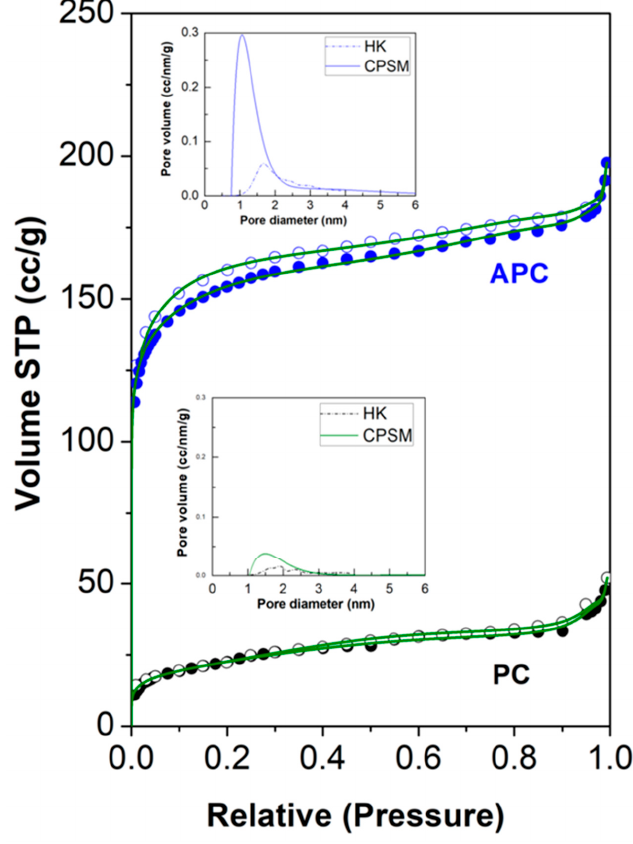
Figure 8. N 2 adsorption (filled circles)—desorption (empty circles) experimental data for PC and APC. The continuous lines show the CPSM model fitting comparison. The inset figures show the pore size distribution (PSD) according to the Horvath–Kawazoe (dash dots) and to the CPSM (line) model.